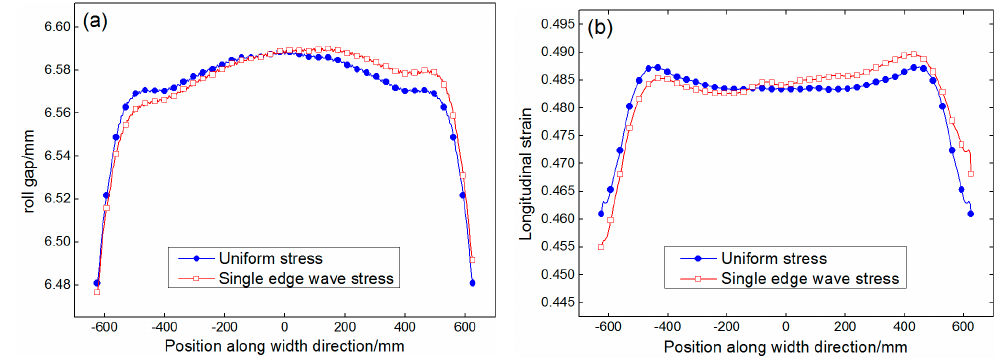
Figure 15. Effect of asymmetric stress on the roll gap profile and longitudinal strain: ( a ) effect on the roll gap profile; and ( b ) effect on the longitudinal strain.